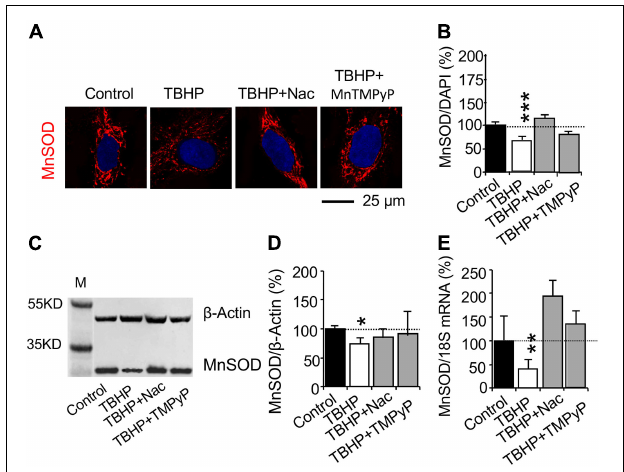
FIGURE 3 | Reactive oxygen species (ROS) affects MnSOD mRNA and protein expression in cultured human brain microvascular endothelial cells (HBMEC) treated with tert-butyl hydroperoxide (TBHP). Cultured cells were incubated with the ROS scavenger N -acetylcysteine (Nac, 5 mM for 15 h) or the cell-permeable SOD mimetic manganese (III) tetrakis(1-methyl-4-pyridyl)porphyrin (MnTMPyP, 25 µ M for 45 min) and were then treated with TBHP at 500 µ M for 1 h and recovered without TBHP, Nac, and MnTMPyP for 3 days. (A,B) Immunohistochemistry and (C,D) western blot analysis were used to study MnSOD protein expression. (E) Quantitative PCR (qPCR) was used to determine MnSOD mRNA expression. Data are reported as mean ± SEM. Asterisks over the bars (* p < 0.05; ** p < 0.01; *** p < 0.001) compared with their according controls, set as 100%. Student’s t -test for mRNA expression and western blot analysis ( n = 4–5 cultures/group) or one-way ANOVA with post hoc Tukey’s multiple comparison test for immunohistochemistry ( n = 42–160 random cells from 3 to 4 cultures per